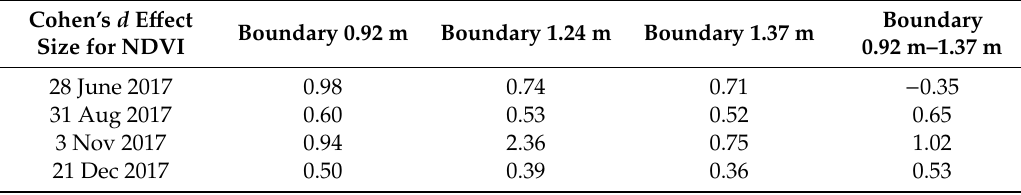
Figure 5. ( A ) Comparison of average NDVI for elevations below and above 1.37 m for four Landsat images in di ff erent seasons. ( B ) Comparison for elevations below and above 1.24 m. ( C ) Comparison for elevations below and above 0.93 m. ( D ) Average NDVI in the persistence zone (below 0.93 m) compared to average NDVI in regenerative zone (above 1.37 m). Bars represent two standard deviations. Table 5. Cohen’s d e ff ect size for the di ff erence between average NDVI computed below and above a specific elevation. The elevation separates the persistence and regenerative